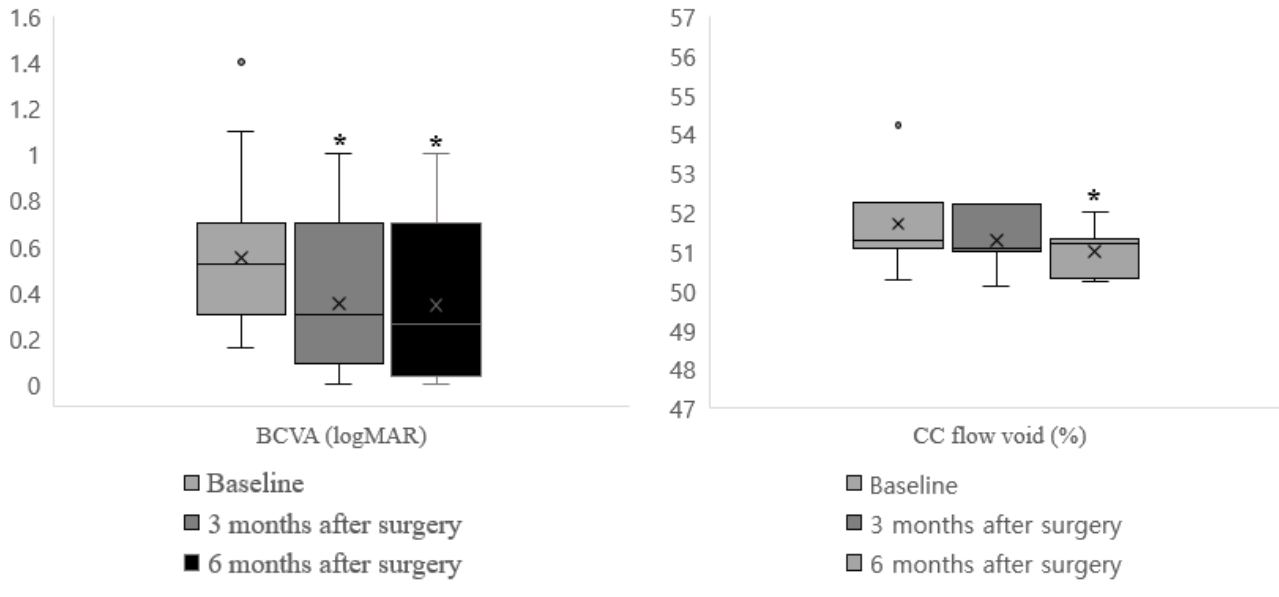
Figure 4. Box-plot graph of BCVA (logMAR) and CC flow void of MH patients. Preoperative data and data at three and six months were compared. BCVA significantly improved three and six months compared to preoperative data ( p < 0.001). Total area of CC flow void decreased three months postoperatively, yet this difference was not statistically significant (p=0.81). However, choriocapillaris flow restored significantly 6 months postoperatively (p=0.031). * P-value <0.05.